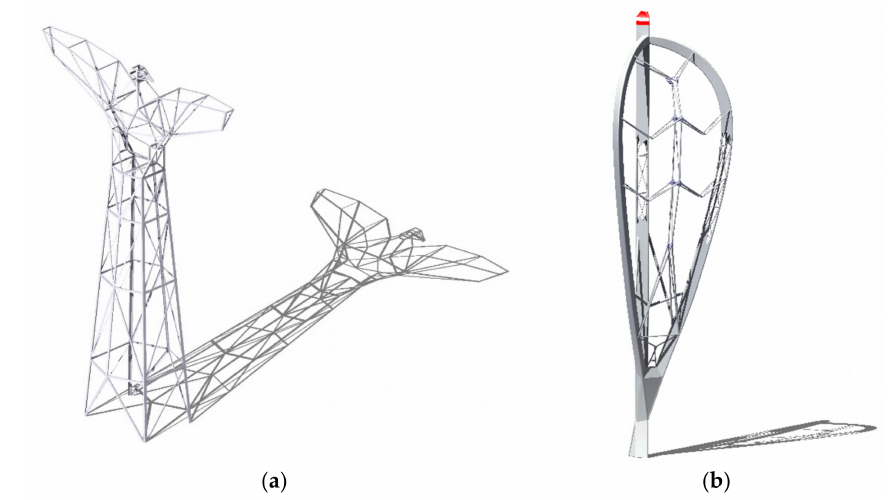
Figure 16. Render of the pylons final structures. ( a ) Eagle; ( b )